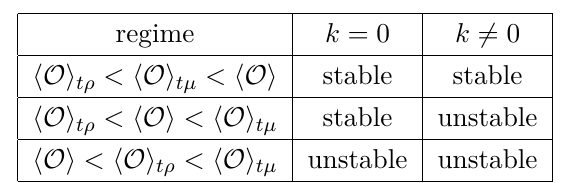
Figure 14 . The speed and attenuation constant v 2 diagram in the case of the 1st order phase transition. The blue branch is the one in which the sound mode is unstable and it corresponds to the regime between the red and blue dashed lines in figure 13.